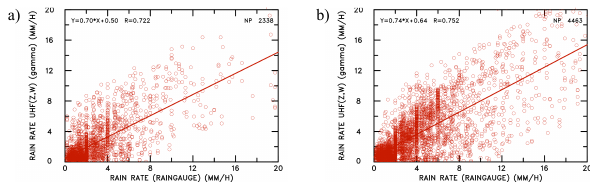
Fig. 3. Scatter plot of radar- and rain gauge-derived rain rate for the periods (a) May 2009–October 2009 (dry season) and (b) Novem- 645 ber 2009–April 2010 (moist season). Radar data are obtained be- Figure 3: Scatter plot of radar- and rain gauge-derived rain rate for the period a) May 2009 - 646 tween 400 and 500ma.m.s.l. Rain gauge data are obtained at sea October 2009 (dry season) and b) November 2009 - April 2010 (moist season). Radar data are 647 obtained between 400 and 500m amsl. Rain gauge data are obtained at sea level. 648 level. 649